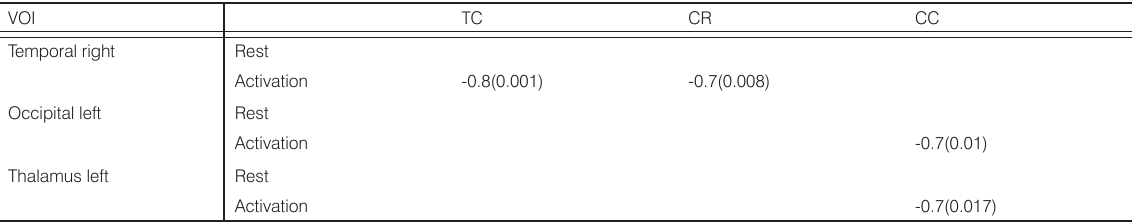
Table 6. Statistically significant negative correlations between Wisconsin Card Sorting Test scores and relative rCBF (correlation coefficient is followed by p in the